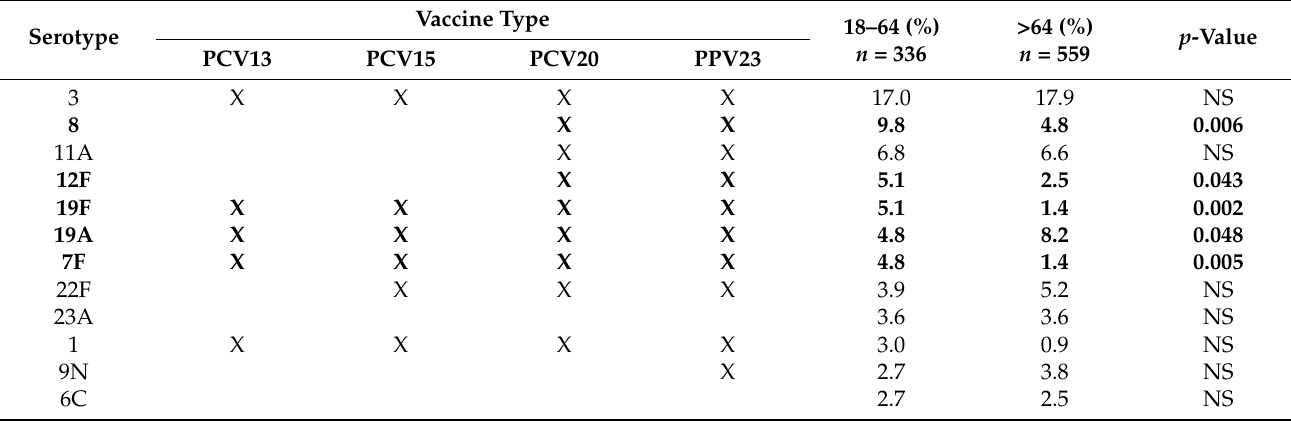
Figure 2. Serotype distribution of pneumococci causing pneumonia by age group. Bars indicate the frequency of each serotype in the particular age group. Table 1. Pneumococcal serotypes causing pneumonia in young and older adults. Data show the frequency of each serotype in the age group. Only serotypes accounting for ≥ 10 episodes are shown. Statistically significant results are highlighted in bold. NS: not statistically significant.